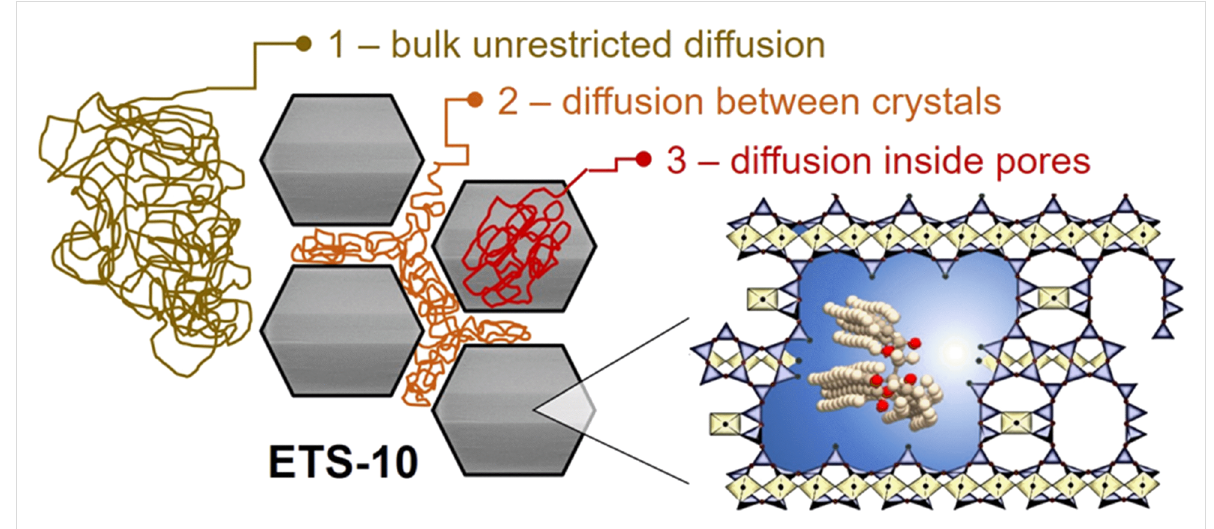
Figure 17: Schematic representation of the diffusion modes denoted as 1, 2 and 3 in the Figure 16 as observed by PFG NMR. The inset represents part of the treated ETS-10 framework with triolein inside it. The sketched trajectories are not to scale – see Table 4 for measured RMSD values.